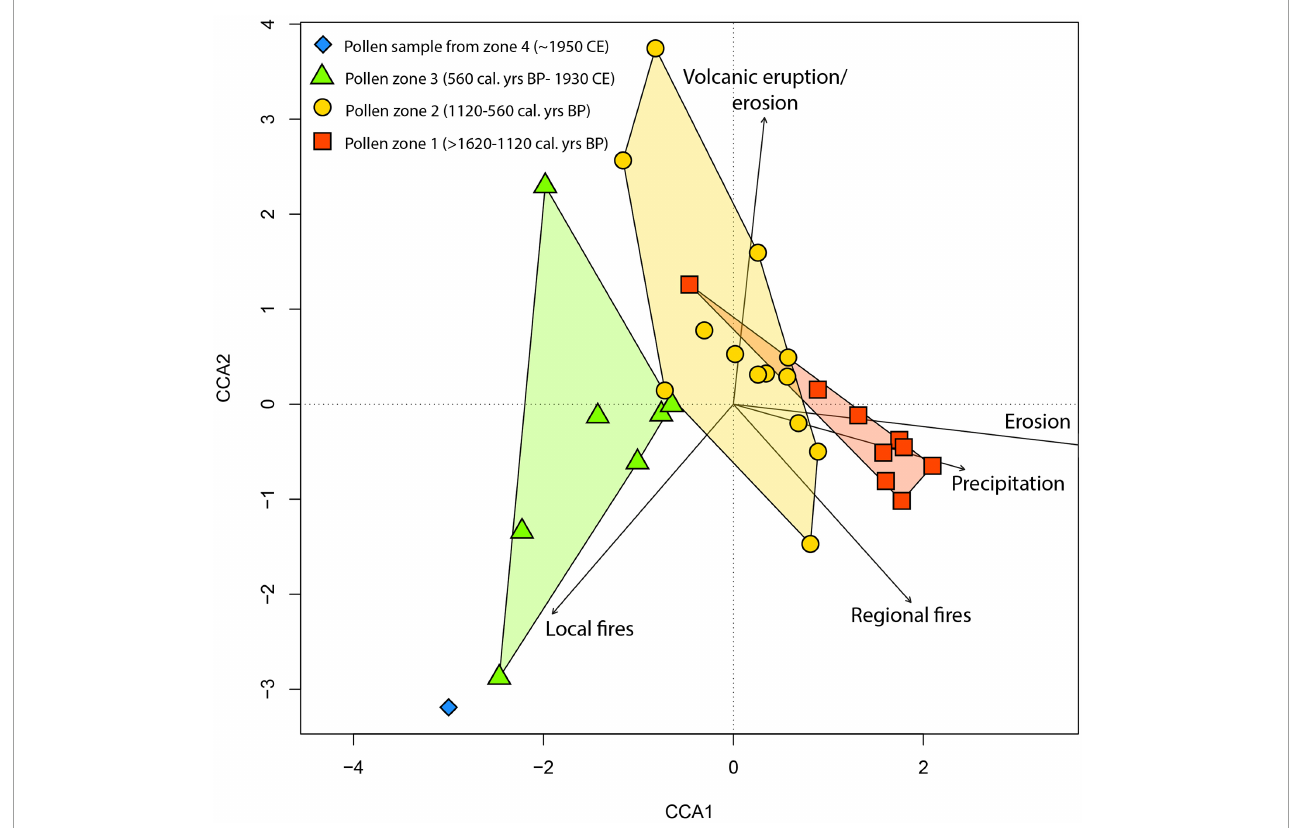
FIGURE6 Canonical correspondence analysis (CCA) of pollen percentages. Environmental variables include regional fires (micro-charcoal), local fires (macro-charcoal), precipitation rate (mm day - 1 ), erosion (Ti/incoherent scatter), and volcanic eruptions/erosion (magnetic susceptibility). Pollen assemblages are coloured according to their